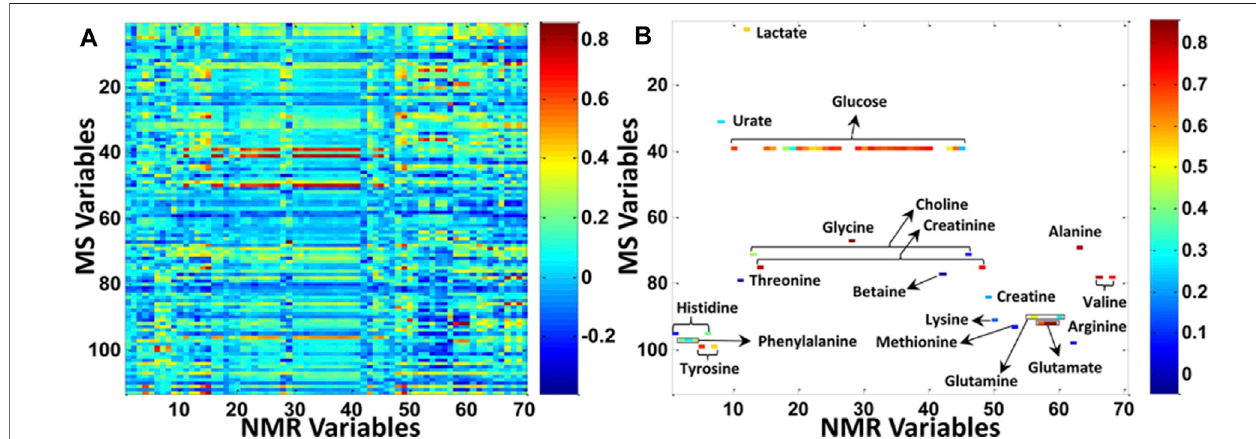
FIGURE 4 | Increasing the metabolic coverage of serum samples from patients suffering from colorectal cancer and polyps, by using both NMR and MS analytical platforms. (A) CorrelationbetweenallNMRandMSvariables. (B) Correlationbetweenthesubsetofmetabolites(labeledinthe fi gure)thatcanbedetectedbybothNMR and MS. The X axis provides an index of all NMR variables in the data matrix, and the Y axis provides an index of all MS variables in the data matrix. Reproduced with permission from (Deng et al.,